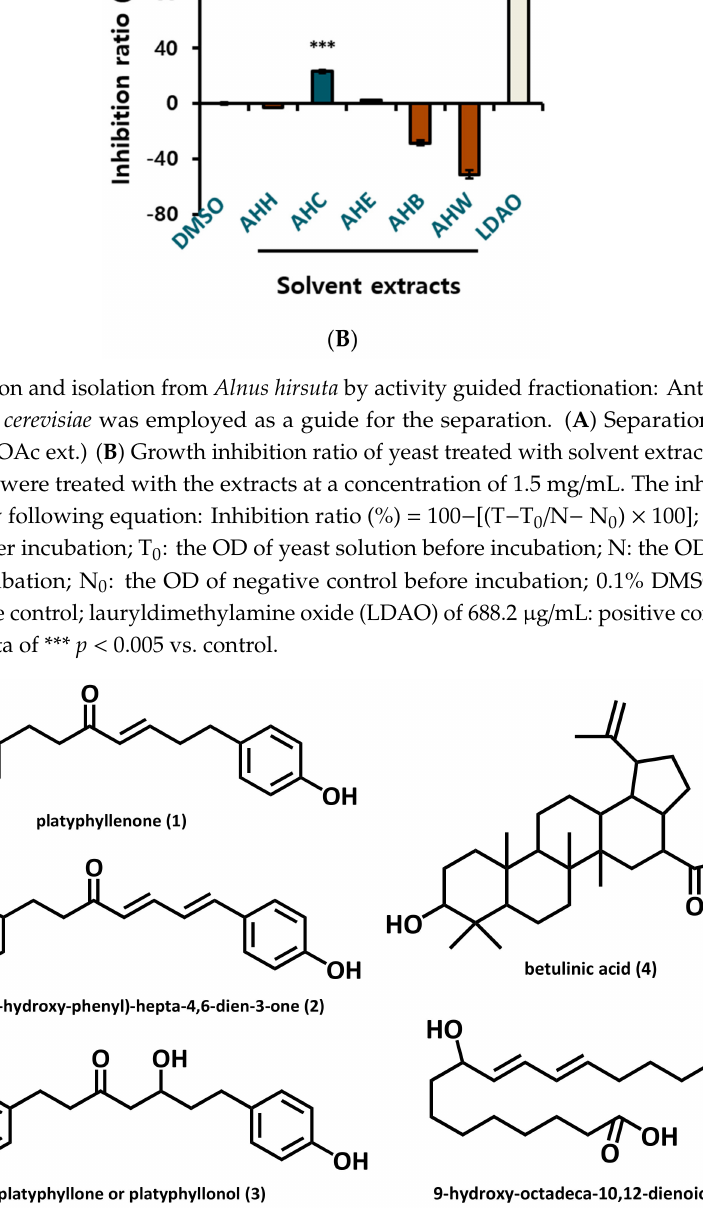
Figure 2. Structures of the compounds 1 – 5 isolated from A. hirsuta CHCl 3 extract